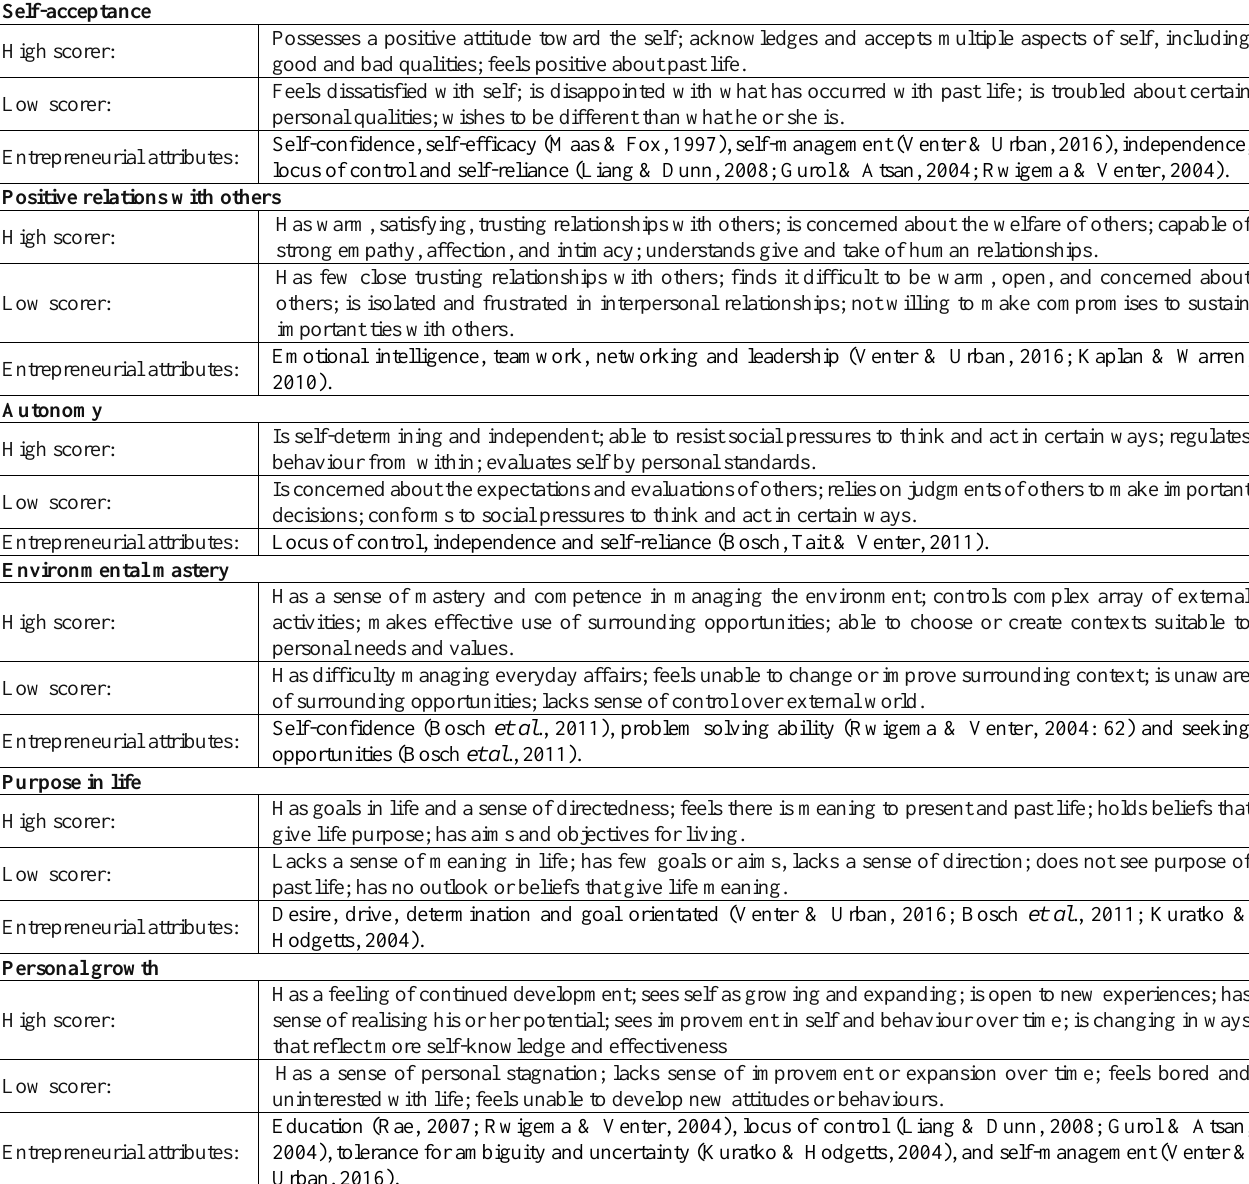
Table 1: Dimensions of psychological well-being and associated entrepreneurial attributes